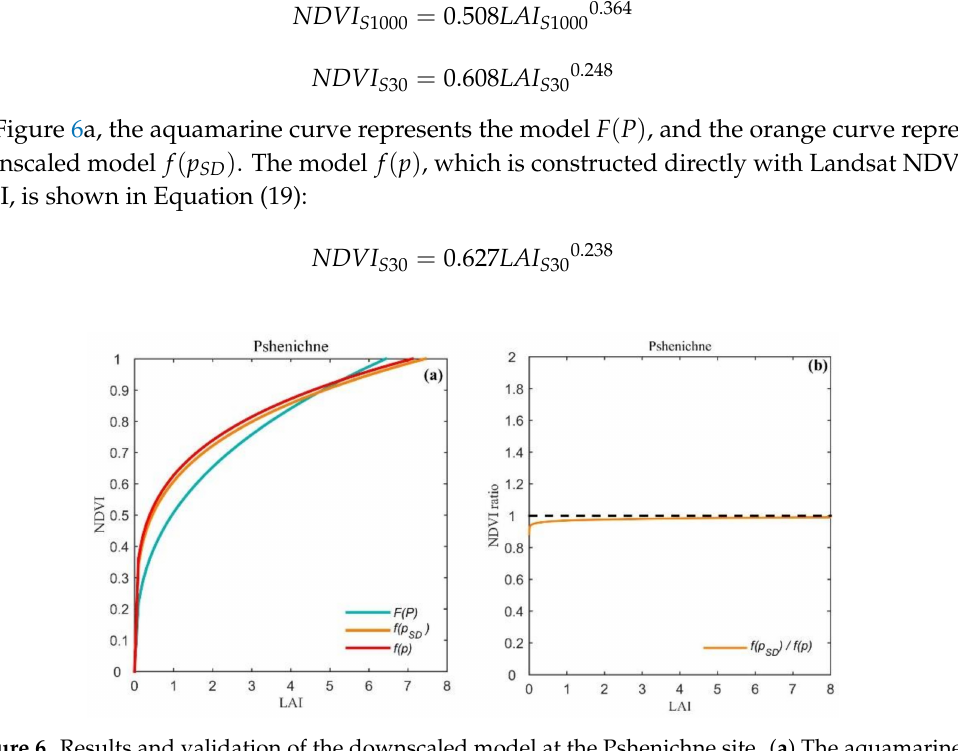
Figure 6. Results and validation of the downscaled model at the Pshenichne site. ( a ) The aquamarine curve is the model F ( P ) at 1 km spatial resolution established by the Ordinary Least Squares (OLS) method; the orange curve is the downscaled model f ( p SD ) established by SEMPs; the red curve is the model f ( p ) at 30 m spatial resolution directly established by the OLS method; ( b ) the orange curve is the NDVI ratio between f ( p SD ) and f ( p )